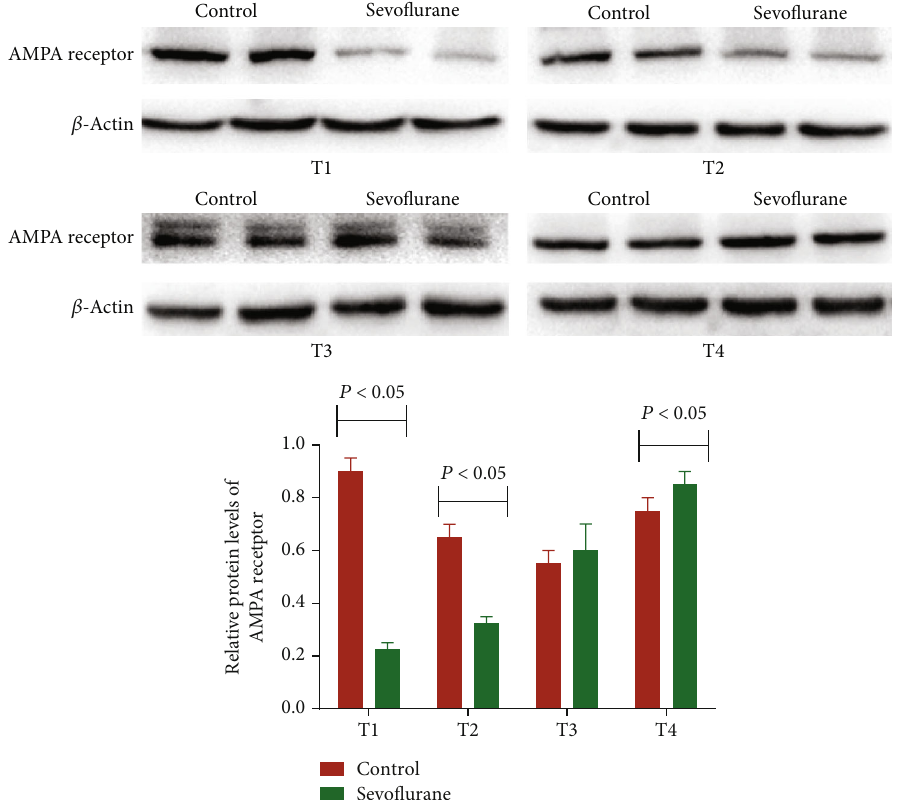
Figure 4: Western Blot analysis of the e ff ects of sevo fl urane on relative protein levels of AMPA receptor. According to the di ff erent time points of the behavioral experiment test, the mice were stopped for the inhalation of sevo fl urane or oxygen after 12h (T1), 24 h (T2), 48h (T3), and 72 h (T4). n = 8 for each group, and the statistical di ff erence was signi fi cant if P < 0 : 05 vs. the control